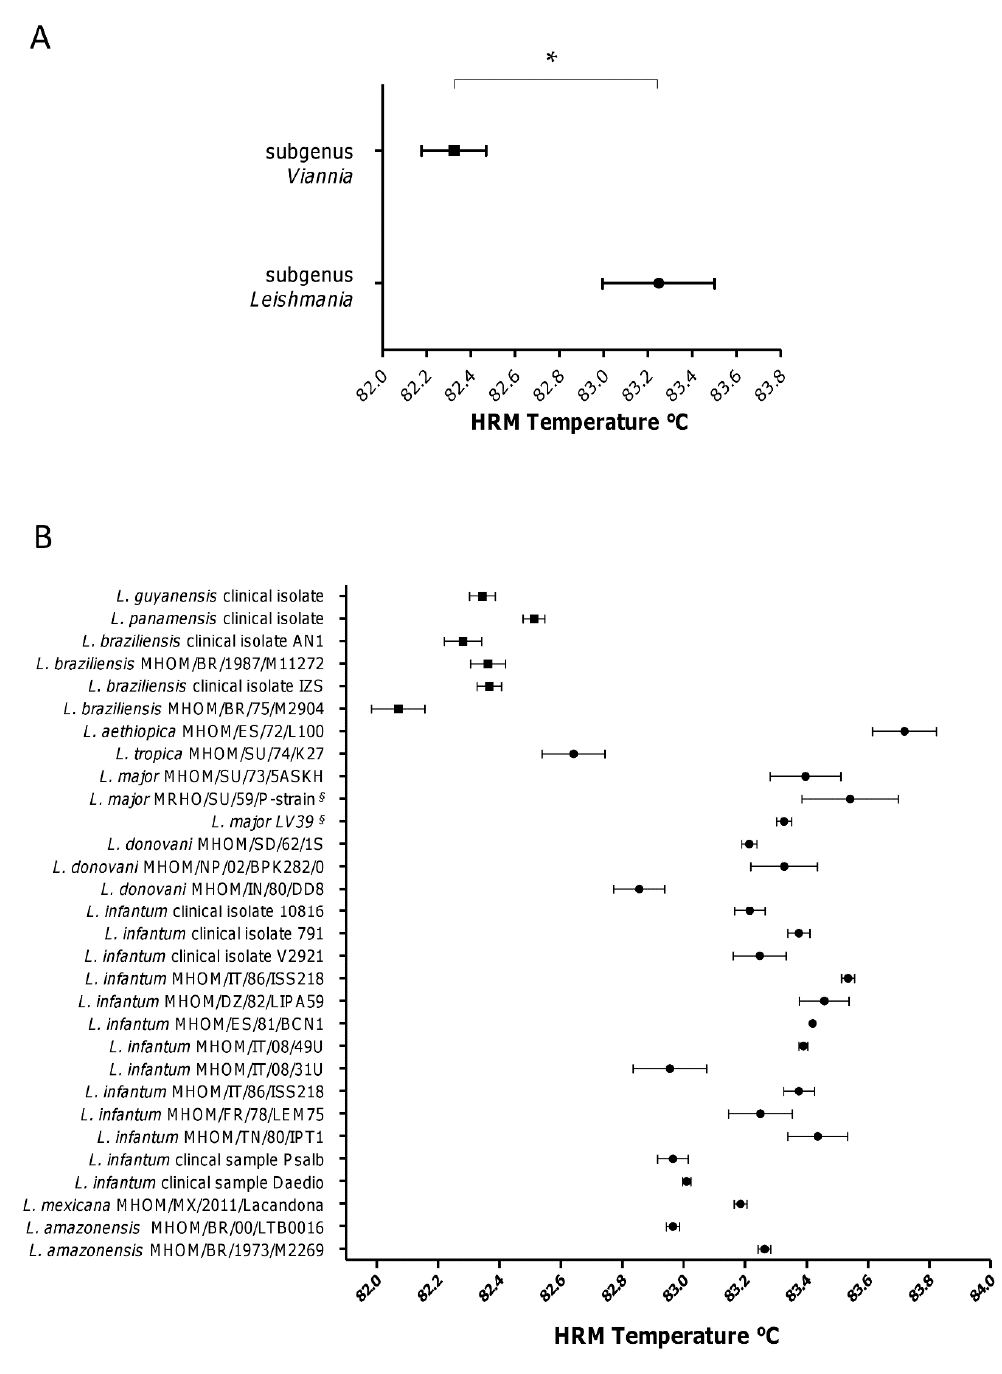
Figure 3. Leishmania spp. qPCR-ML HRM temperatures analysis. ( A ) Comparison between HRM temperatures (mean and standard deviation) of all tested samples belonging to subgenus Leishmania (n = 24) and Viannia (n = 6). * p < 0.05 Mann–Whitney test. ( B ) HRM temperature distribution of all samples tested. Squares and circles represent species belonging to subgenus Viannia and Leishmania , respectively. Mean values and standard deviations of at least three replicates are shown. § synonym strains coming from different laboratories.